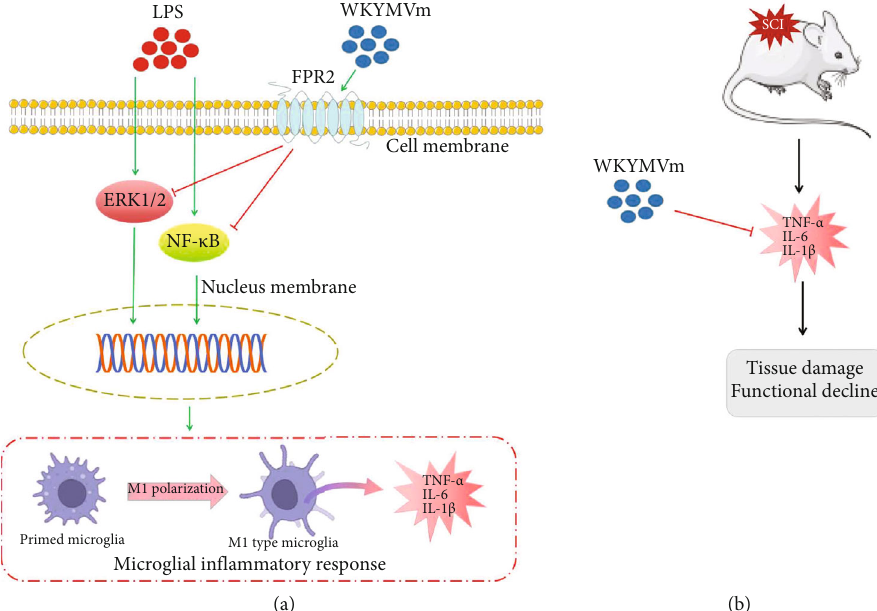
Figure 9: Working model showing the e ff ect of WKYMVm in vitro and in vivo. (a) WKYMVm suppresses the ERK1/2 and NF- κ B signaling pathways, attenuates M1 microglial polarization, and reduces in fl ammatory cytokines expression in vitro. (b) WKYMVm reduces tissue damage and functional decline after SCI via inhibiting in fl ammatory cytokines in vivo. LPS: lipopolysaccharide; FPR2: formyl peptide receptor 2; ERK1/2: extracellular response kinases 1 and 2; NF- κ B: nuclear factor- κ B; SCI: spinal cord